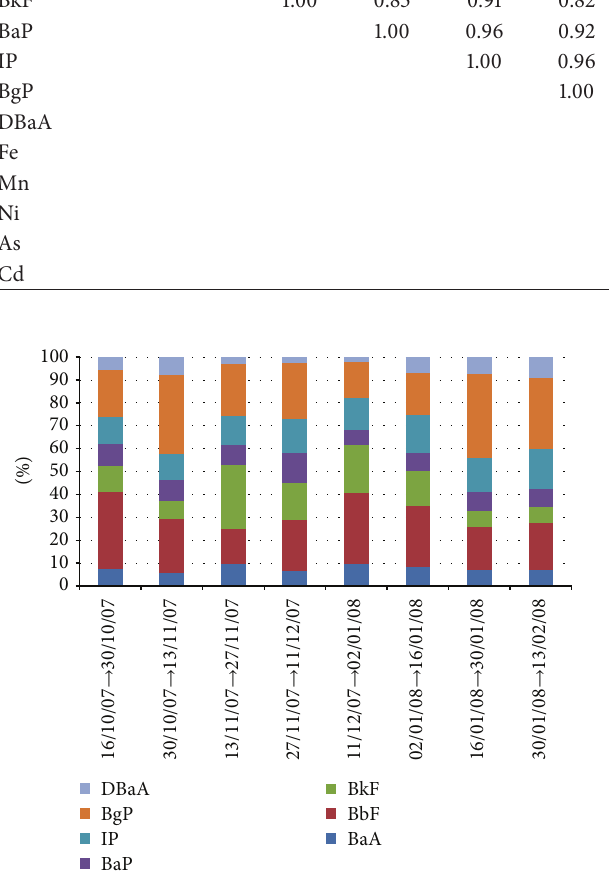
Figure 6: Fe deposition fluxes ( 𝜇 gm −2 d −1 ), wind speed (m/sec), and probability of wind direction (WDP) from North-North-West (NNW) in percentage at the industrial